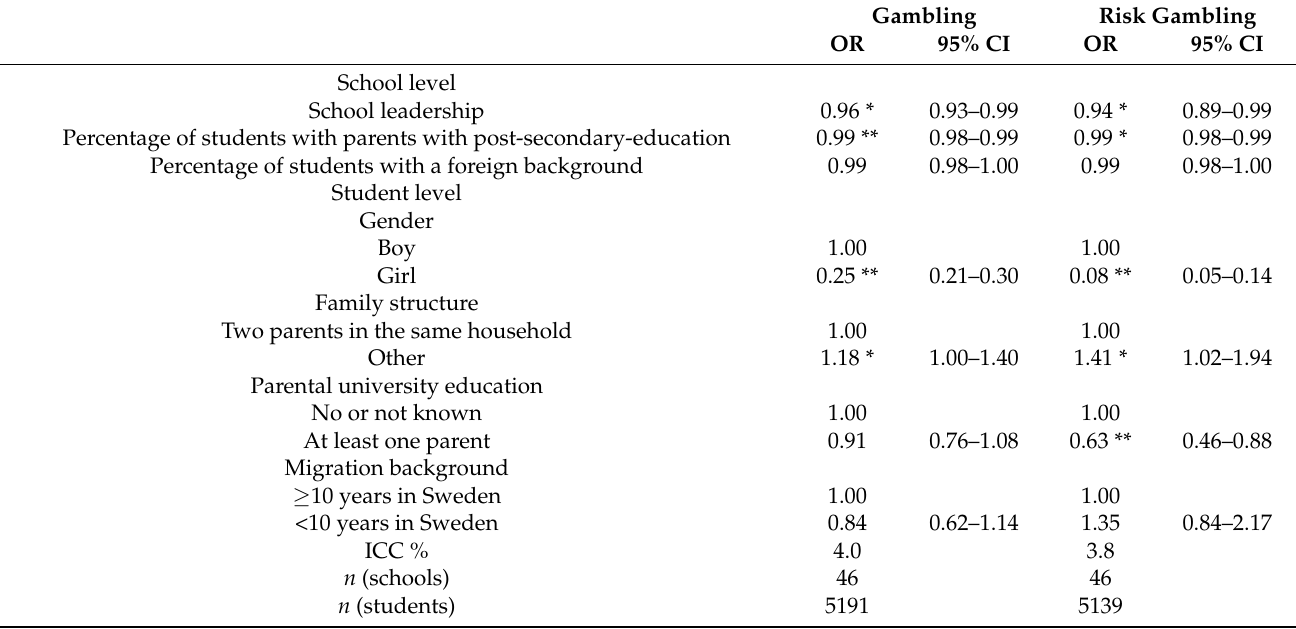
Table 2. Odds ratios and 95% confidence intervals from two-level binary logistic regression of gambling and risk gambling.